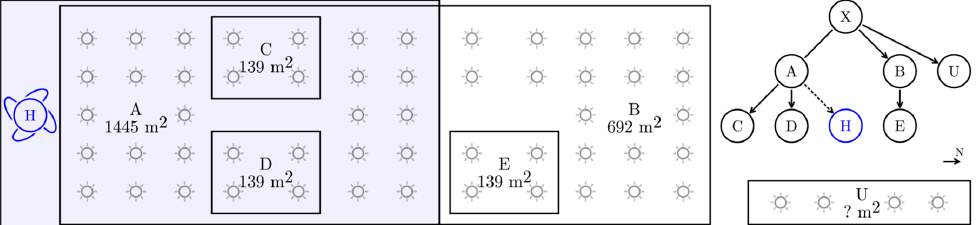
Figure 2. Example floor of the case building with lights and the feeds relationships of the electrical distribution tree. A, B, C, D, E and H are submeters, X is a main meter, and U is an unknown component being fed by meter X.